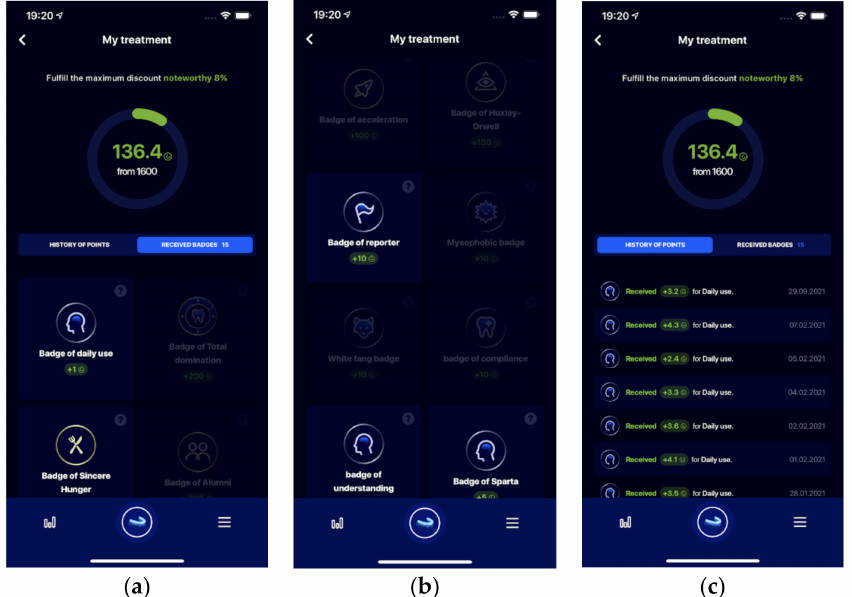
Figure 6. Screens of StrojCHECK ® app regarding incentives: ( a ) Patient view of gained points that equal total discount from the treatment budget ( b ) Achieved incentives(badges) and other badges to be achieved are introduced grayed, dynamically introduced by the system. ( c ) List of gained points by following the rules and fulfilling motivational bonuses offered by the system (as special motivational